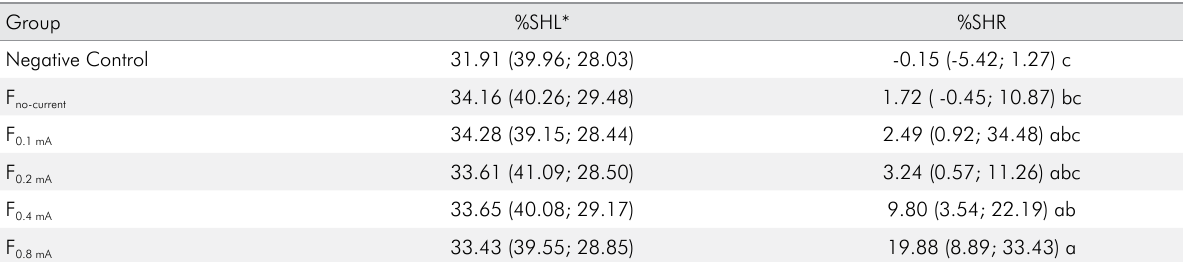
Table 1. Median values (maximum and minimum) of percentage of surface hardness loss (%SHL) and of surface hardness recovery (%SHR) of the dental blocks in the different groups (n =